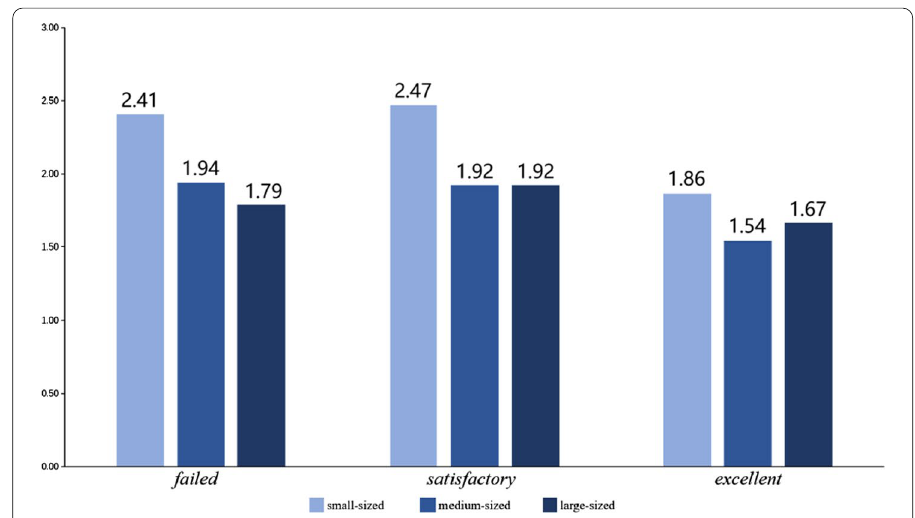
Fig. 2 Weekly session distribution for the three groups